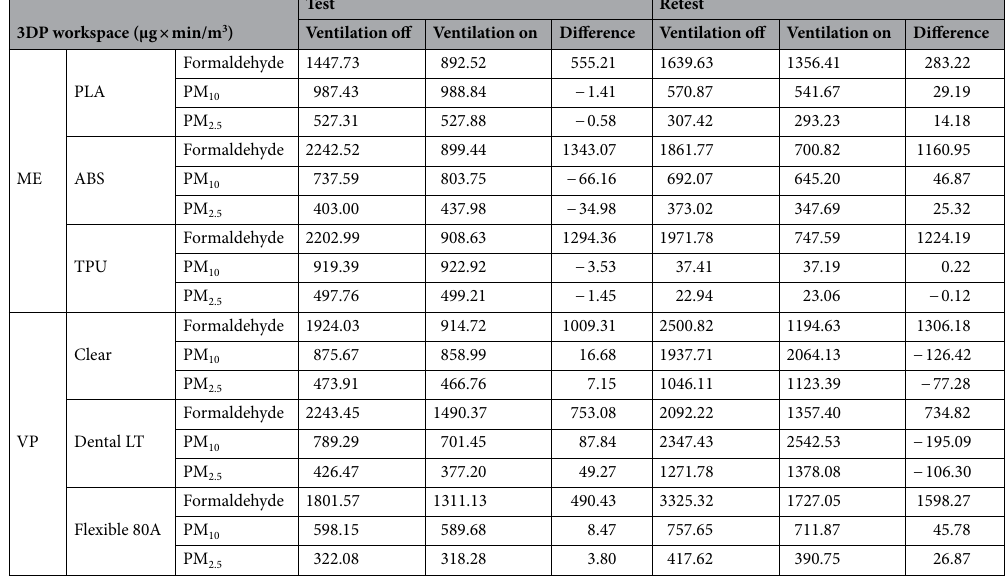
Table 3. The comparison of the area for emission amount based on ventilation in the 3D workspace. 3DP 3D printing, ME materials extrusion, PLA polylactic acid, PM 10 particulate matter 10, PM 2.5 particulate matter 2.5, ABS acrylonitrile butadiene styrene, TPU thermoplastic polyurethane, VP vat